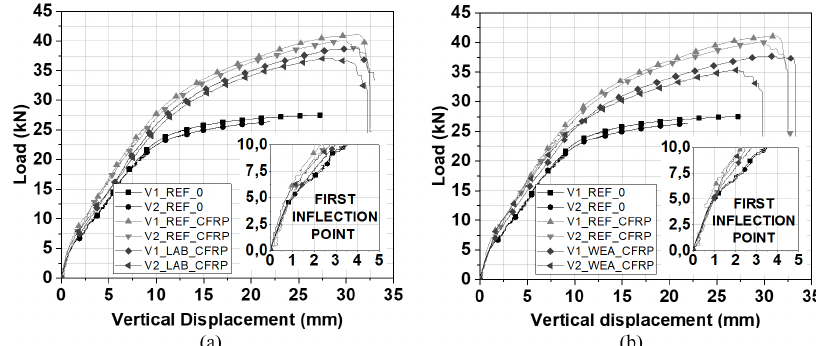
Figure 16. Relationship between Load versus vertical displacement of reference beams exposed to the environments: (a) laboratory and (b)